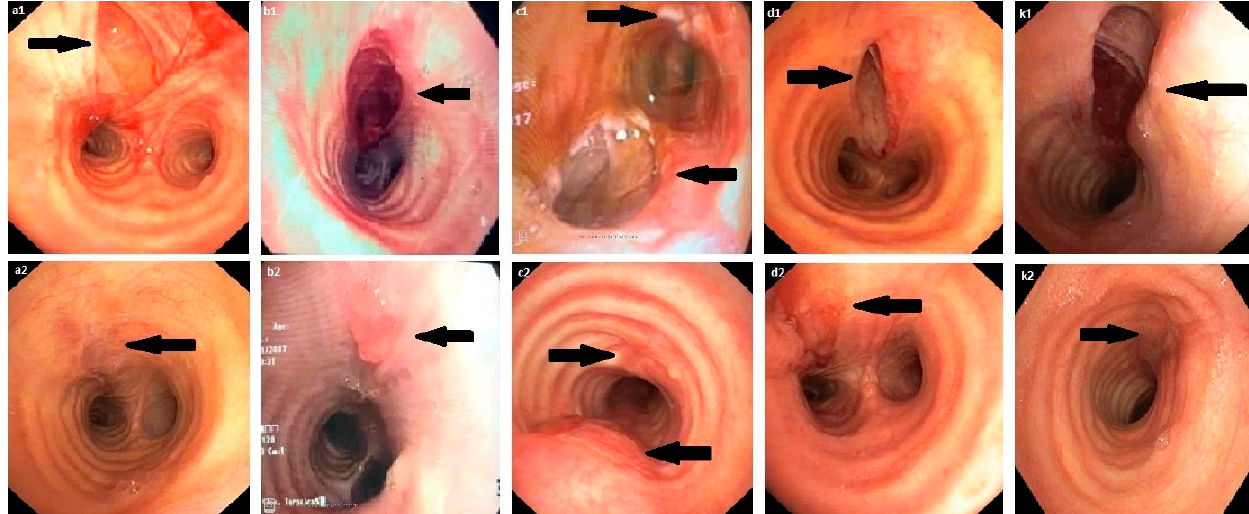
Figure 1. Endoscopic findings at the time of diagnosis and one month after in patients with tracheobronchial injuries (Division of Thoracic Surgery, “A. Businco” Oncology Hospital, Cagliari, Italy). From ( a1 – k1 ): endoscopic TBI visualization at time of diagnosis in patients as listed in Table 2; form ( a2 – k2 ): endoscopic visualization of TBI one month after diagnosis in patients as listed in Table 2.